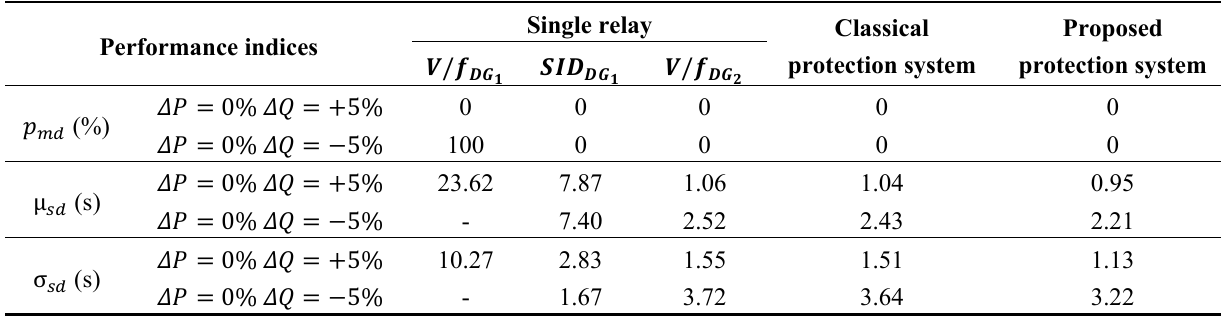
Table 12. Comparison between the classical and the proposed protection systems in the Case B. Single relay Classical Performance indices protection system